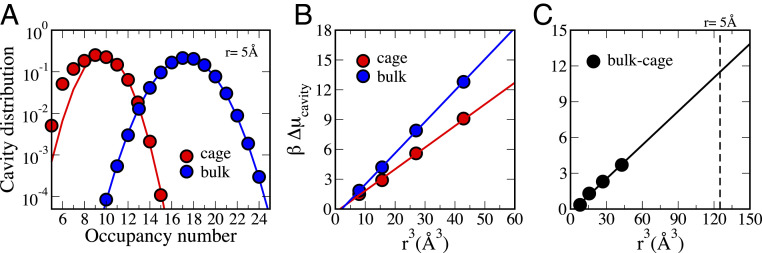
Cavity distributions and cavitation free energies for water in a sphere radius of 5.0 Å within the supramolecular cage and in the bulk. (A) The computed occupancy data for the cage (red) and bulk water (blue) are compared to Gaussian distributions (solid lines). The maximum probable occupancy number n = 9 observed for the 5.0-Å cavity within the cage is obtained in the bulk for a smaller cavity of 4.0-Å radius. (B) Cavitation free energy (Δμcav) inside the cage (red) compared to bulk (blue) as a function of the cavity volume. The circles represent the calculated Δμcav values for r = 2.0, 2.5, 3.0, and 3.5 Å, while the solid lines are linear fits. The linear trends indicate that Δμcav scales with the cavity volume both inside the cage and in the bulk. (C) Difference between Δμcav in the bulk and inside the cage as a function of cavity size, obtained by subtracting the red to the blue curve in B. The linear trend of the difference values vs. cavity volume allows to extrapolate to r = 5 Å (vertical dashed line, corresponding to the cavity formed by [Et4N]+). A value of 11.6 kbT is obtained from the extrapolation.